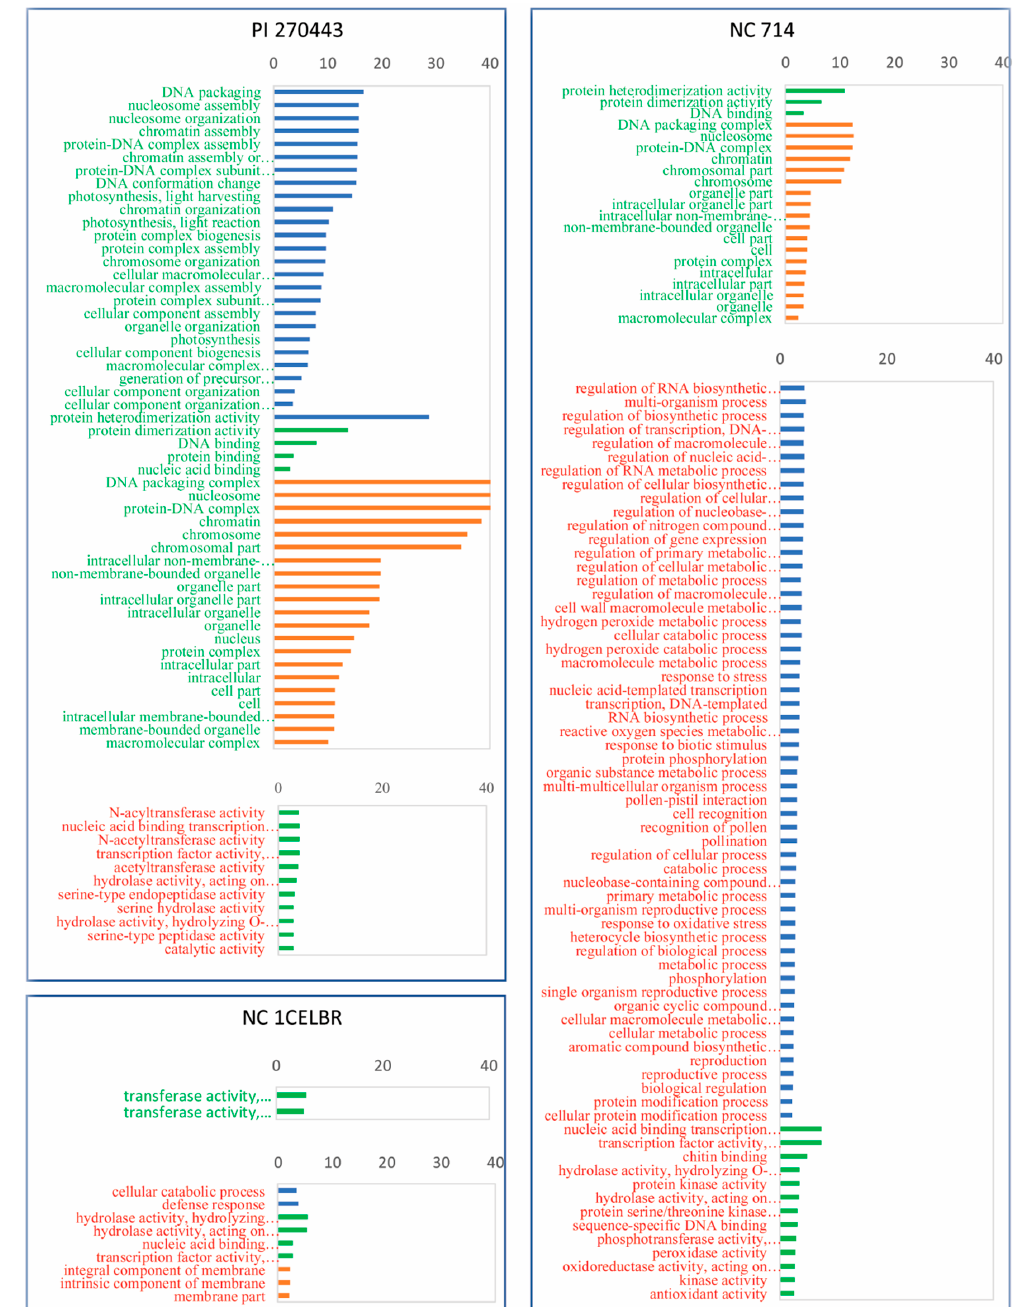
Figure 4. GO terms enriched for DEGs in different tomato lines after BS inoculation. Labels in green and red represent upregulated and downregulated DEGs, respectively. Bars colored in blue, green, and orange represent a biological process, cellular component, and molecular function GO category, respectively. Scale is log10 (1/ p value) .